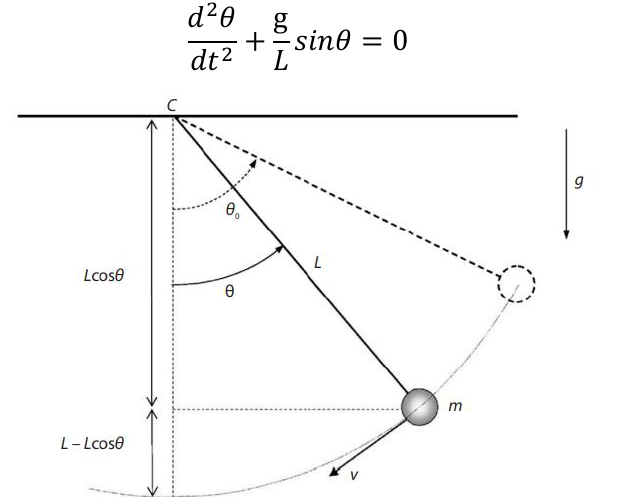
Figure 1 . Scheme of a simple pendulum motion [22]